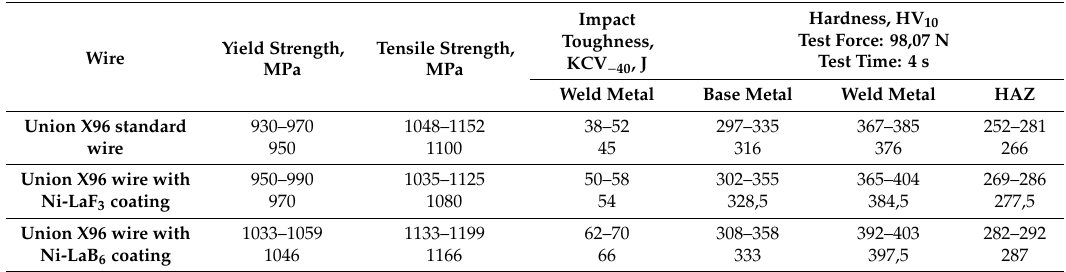
Table 6. The mechanical properties of the welds of S960QL steel with Union X96 wire.